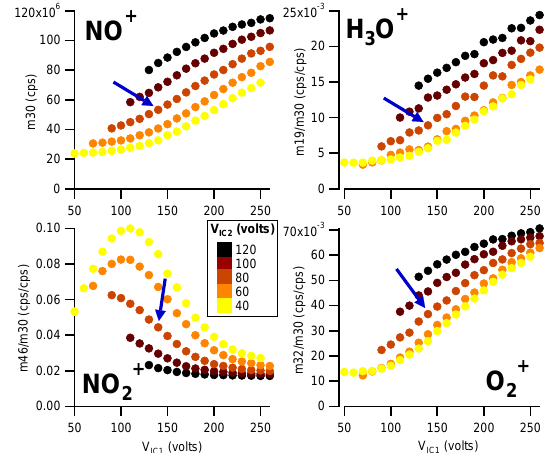
Figure 1. Dependence of NO + , H 3 O + , NO + diate chamber voltages. The arrow denotes the selected operating conditions. Experiment conducted in dry air (H 3 O + is from resid- ual water in the instrument and in commercial ultra-zero air.)